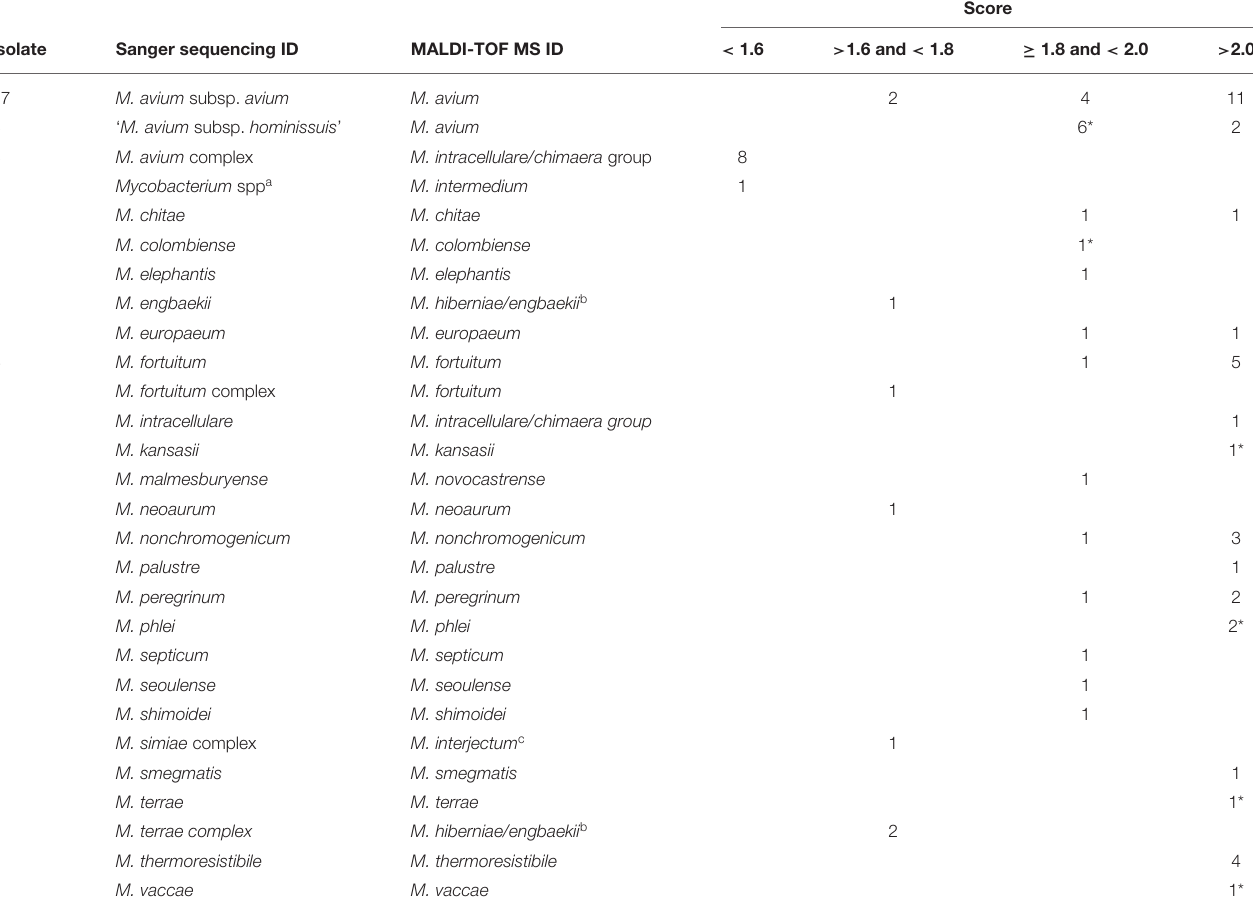
TABLE 2 | Species identification comparison between Sanger sequencing and MALDI-TOF MS (v3.0).